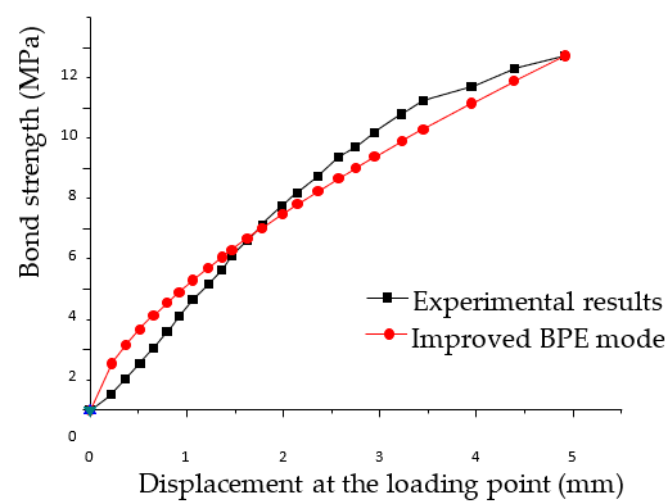
Figure 7. Comparison between the improved BPE model and the experimental results.